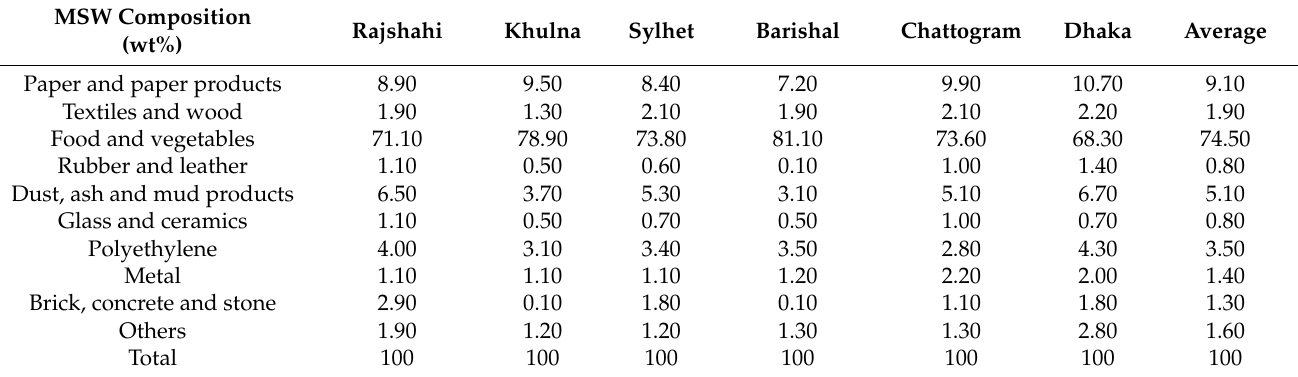
Table 2. Physical composition of MSW in different cities of Bangladesh [23].